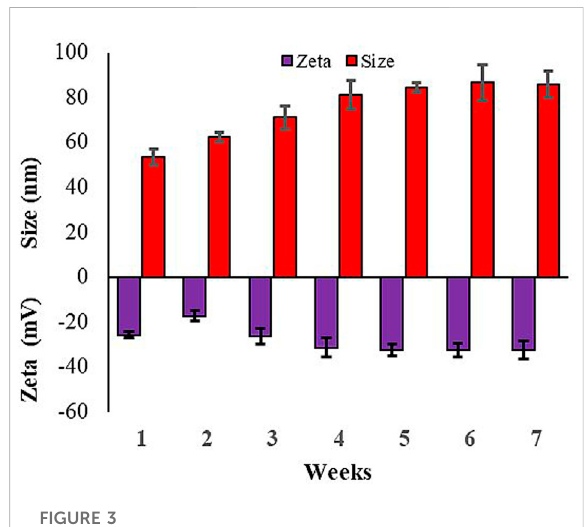
FIGURE 3 Variation in particle size distribution and zeta potential of Rn- AgNPs across